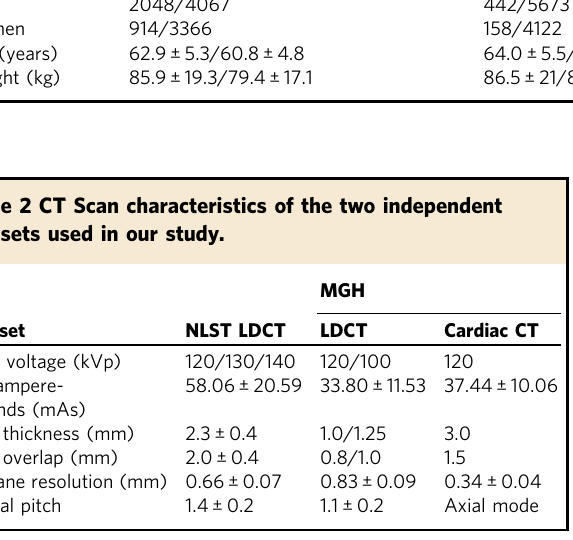
CVD-related mortality based on the ICD-10 codes provided in the dataset. The selected ICD-10 codes are shown in Supple- mentary Table 1. Note that all subjects with CVD-related causes of death were considered CVD-positive.